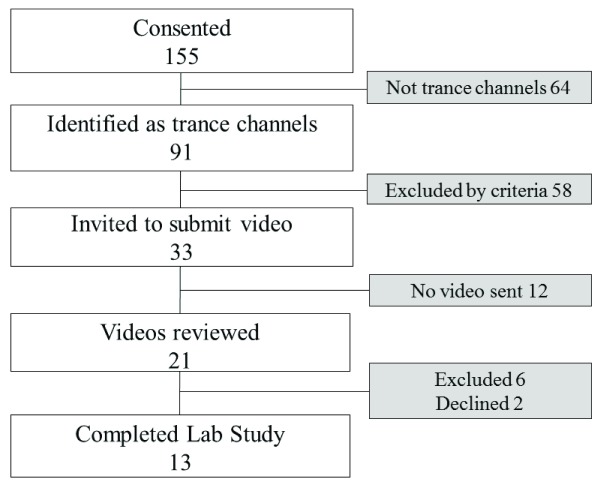
Recruitment diagram.